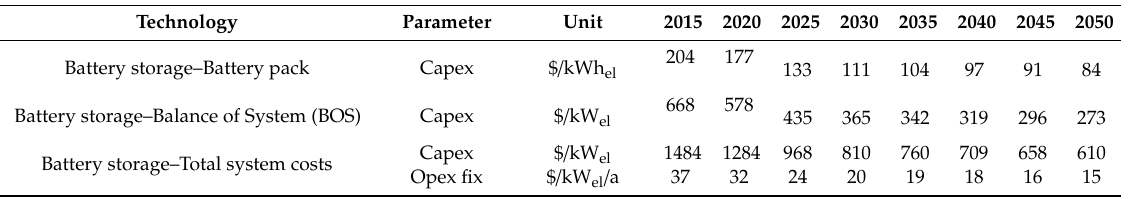
Table A7. Higher costs assumptions for battery storage assumed in the LME scenario and sensitivity case (all costs are in US $2018). Data based on References [38–40,92].